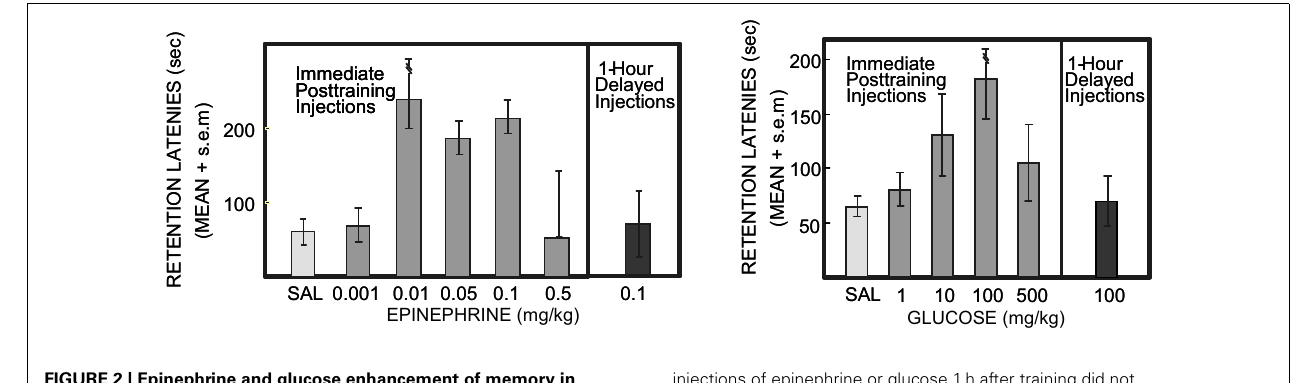
FIGURE 2 | Epinephrine and glucose enhancement of memory in rats. Rats were trained in a one-trial inhibitory avoidance task, received injections of saline, epinephrine, or glucose immediately after training, and were tested 24h later. Note the inverted-U dose-response curves for enhancement of memory seen on the test trial. Note also that